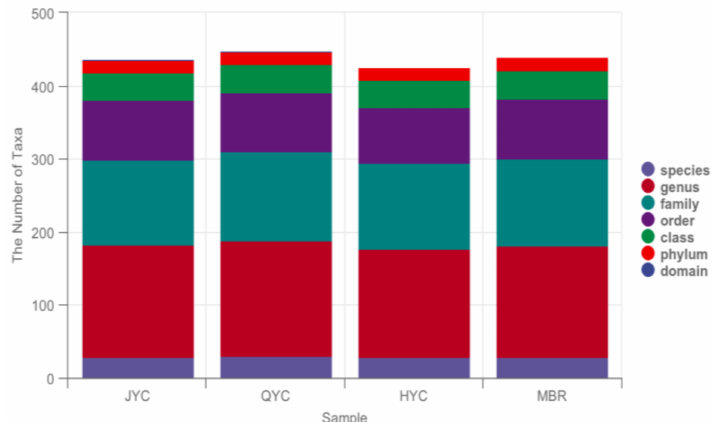
Figure 13. The number of ASVs/OTUs in samples JYC, QYC, HYC, and